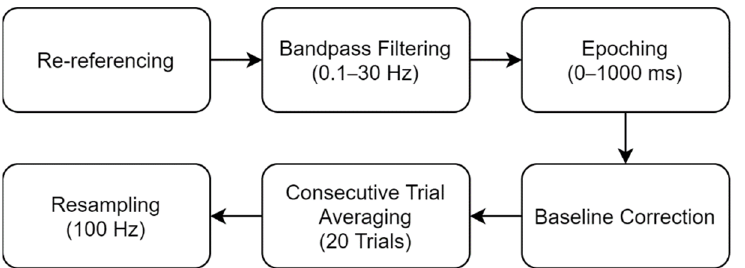
Figure 1. The structure of the drone control system overall. Figure 2. Signal processing procedure.